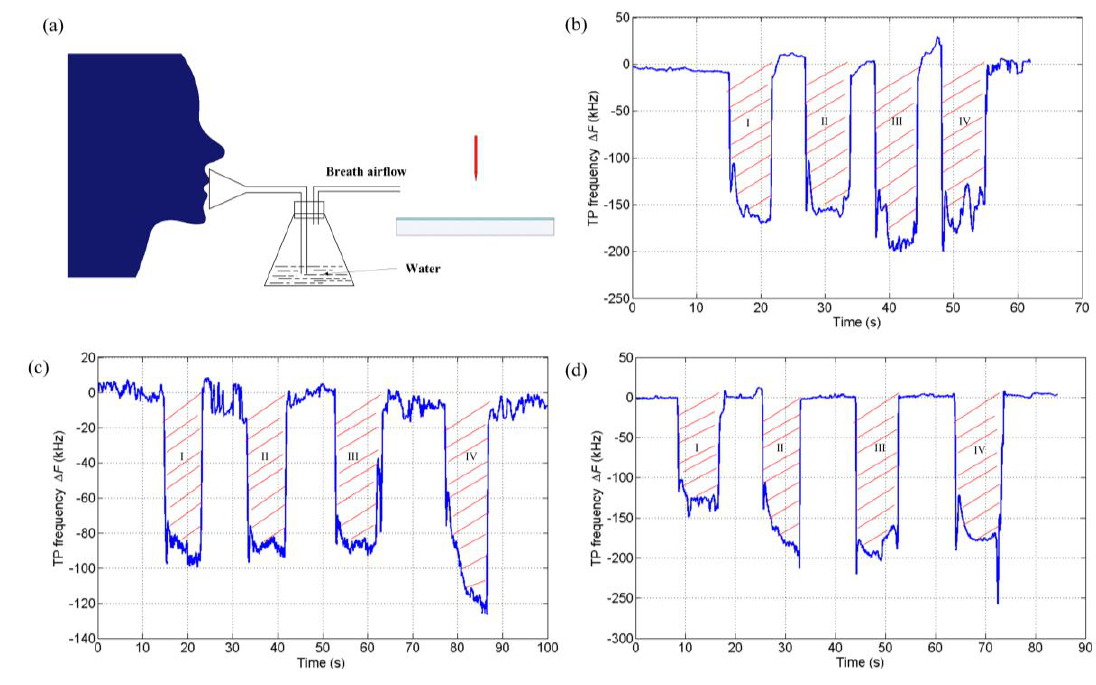
Figure 4. ( a ) Experiment scheme for the vital capacity assessment; ( b ) Variations of TP frequency for VC testing for subject No. 1; ( c ) For subject No. 2; ( d ) For subject No.